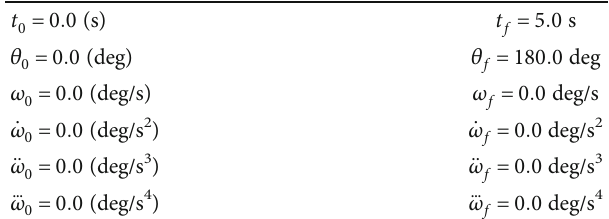
Table 4: Boundary conditions for attitude trajectory